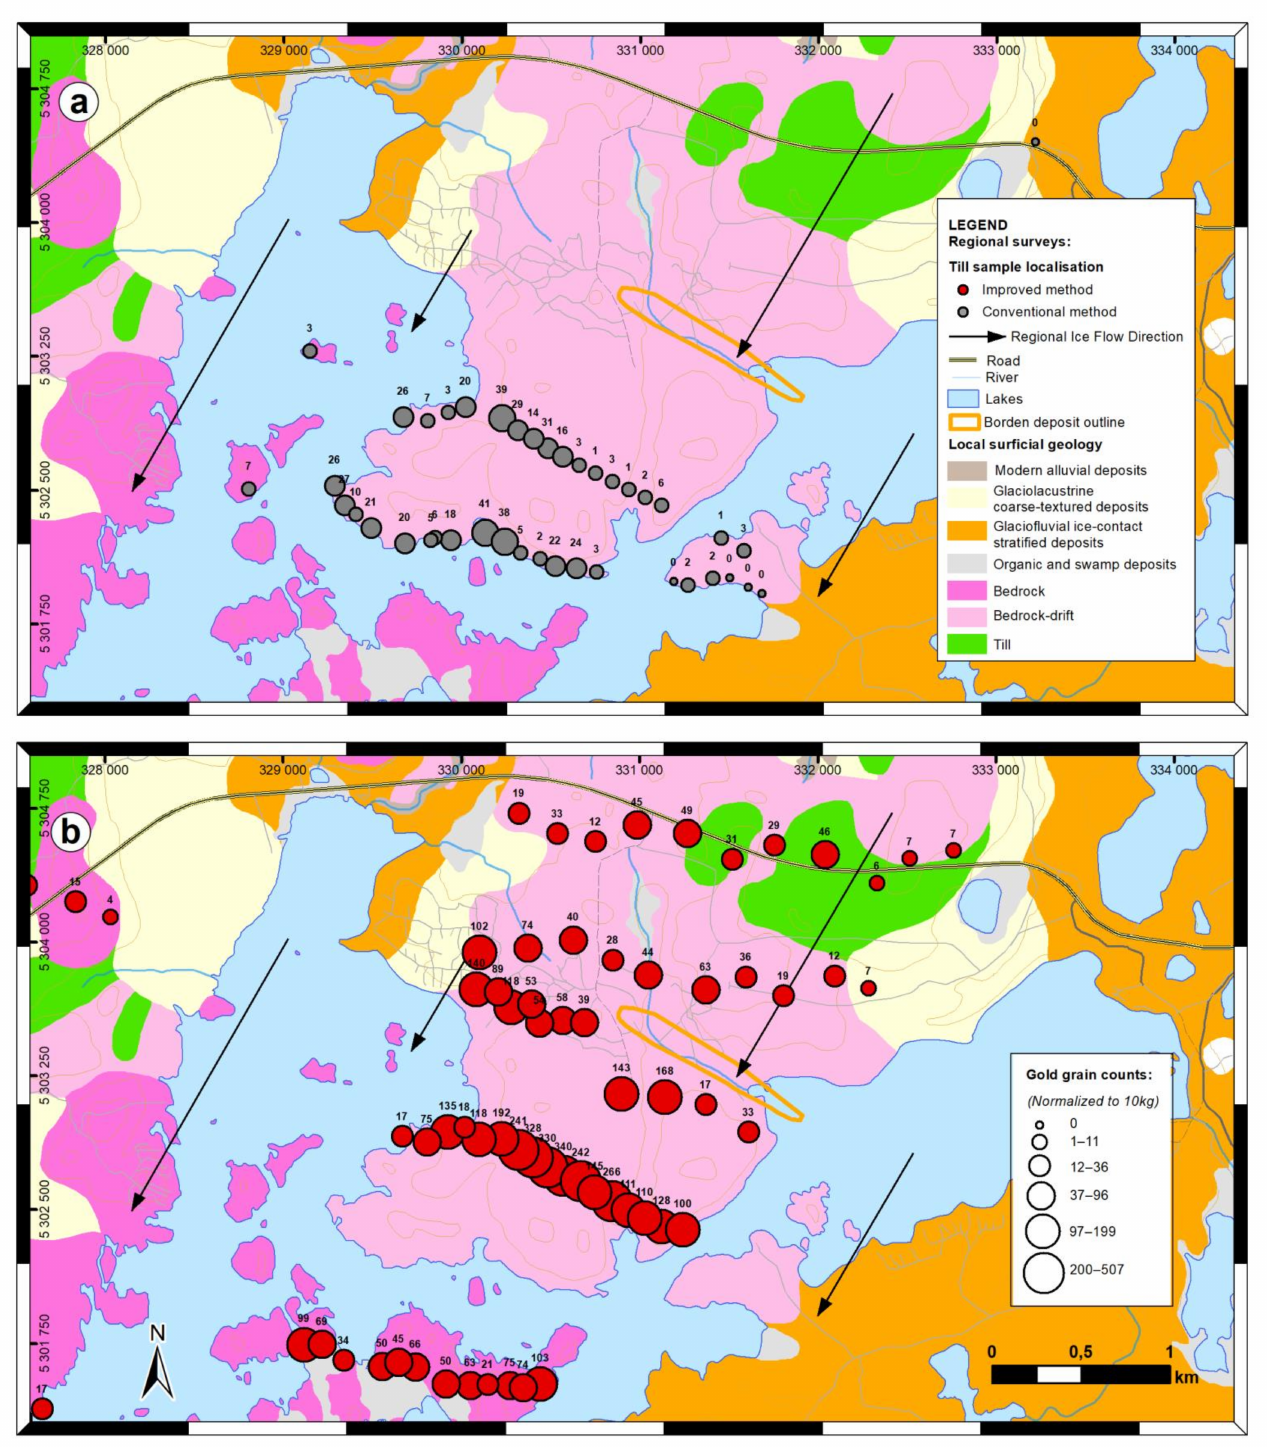
Figure 8. Map of the local area surrounding the Borden gold deposit, showing a surficial geology and the locations of the till samples (orientation surveys) processed with the conventional method ( a ) and the improved method ( b ). The number of samples for the conventional n = 40 and for the improved method n = 61 should be noted. The bubble diameter refers to the gold grain count normalized to a 10 kg sample. On the main profile down-ice of the deposit, samples for the improved method were collected in the same location (within GPS accuracy) from the previous conventional survey and can be considered as paired